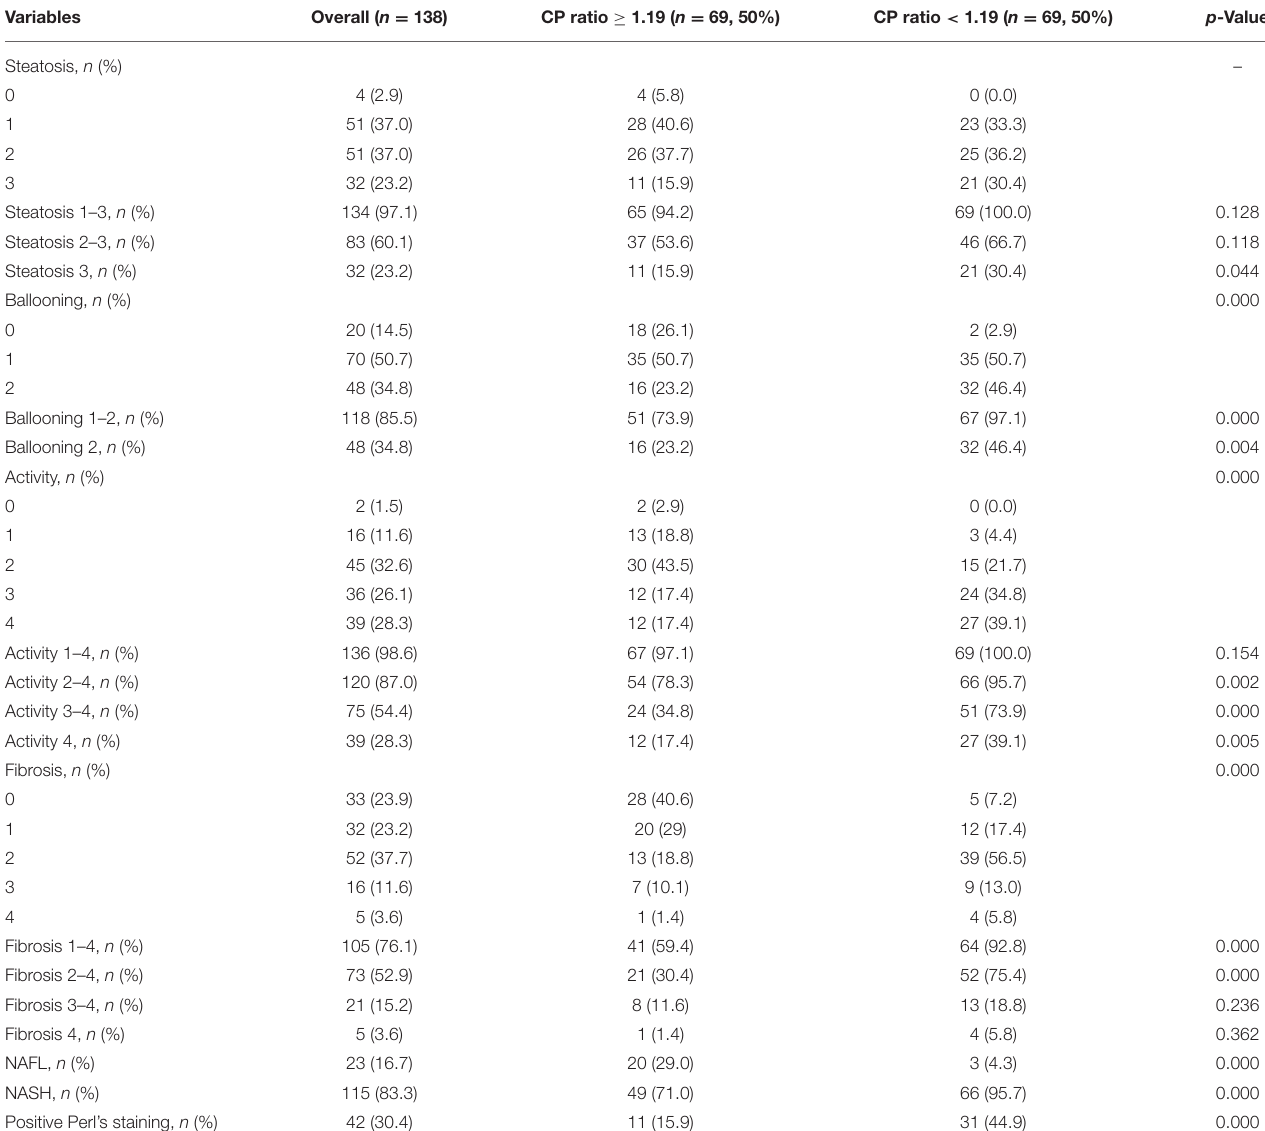
TABLE 2 | The histopathological features of patients in the low and high CP ratio groups.